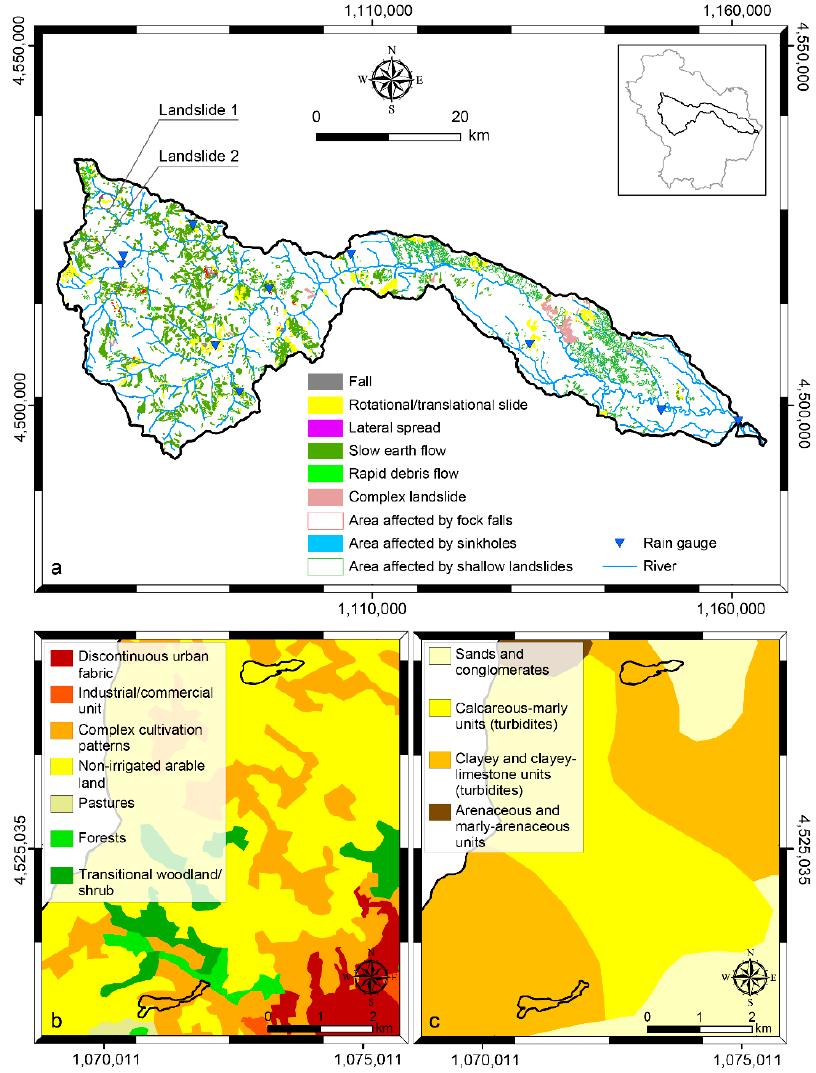
Figure 6. ( a ) Boundaries of the Basento river catchment with indications of the main landslide types according to the IFFI database (https://idrogeo.isprambiente.it/app/; accessed on 1 September 2022), of the rain gauges and of the two selected landslides. ( b ) Land cover of the areas of the selected landslides according to the 2018 CORINE Land Cover map (https://land.copernicus.eu/pan-european/corine-land-cover/clc2018; accessed on 1 September 2022). ( c ) Geo-lithological settings of the areas of the selected landslides according to the Italian geo-lithological map (http://www.pcn.minambiente.it/mattm/servizio-di-scaricamento-wfs/; accessed on 1 September 2022). With reference to the boundaries of the selected rotational slide and earth flow, Figures 7 and 8 show the surface displacements for the T146 ascending orbit and T124 descending orbit, respectively, classified according to the average velocity of deformation over observation period.